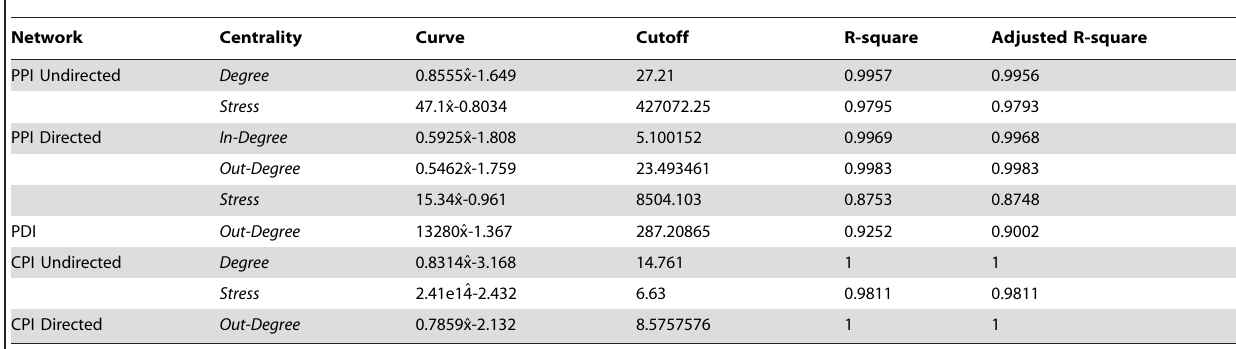
Table 2. Results of node centrality analysis.